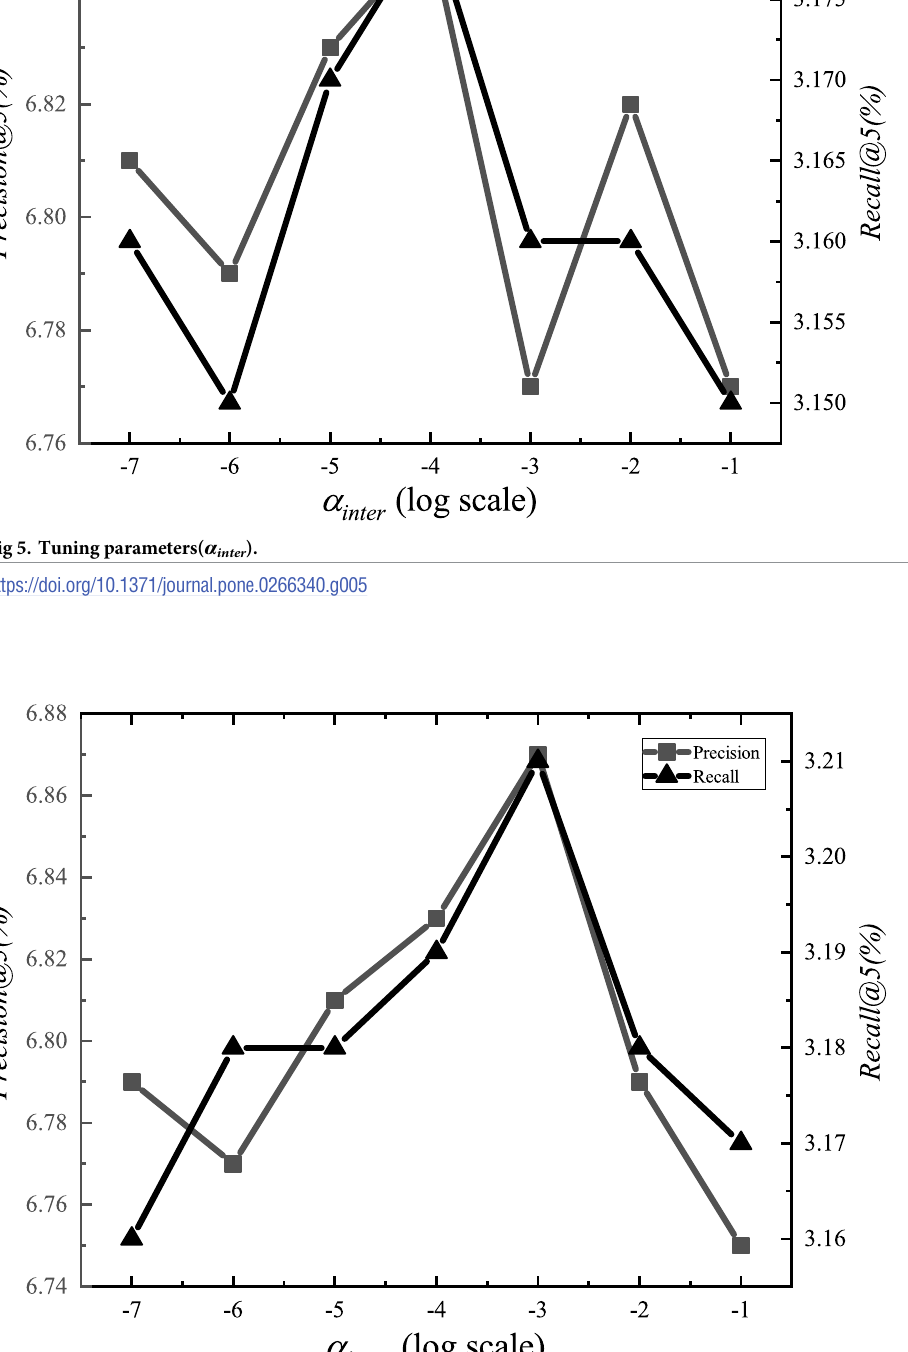
Fig 6. Tuning parameters( α